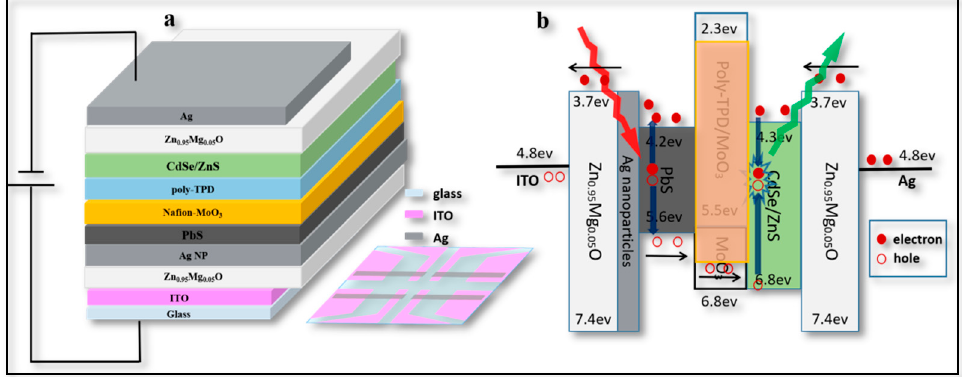
Figure 3. Structure of UCD. ( a ) Schematic cross-sectional view of UCD structure, inset is a top view of the device structure. ( b ) Energy level diagram of each film and carrier transfer mechanism.